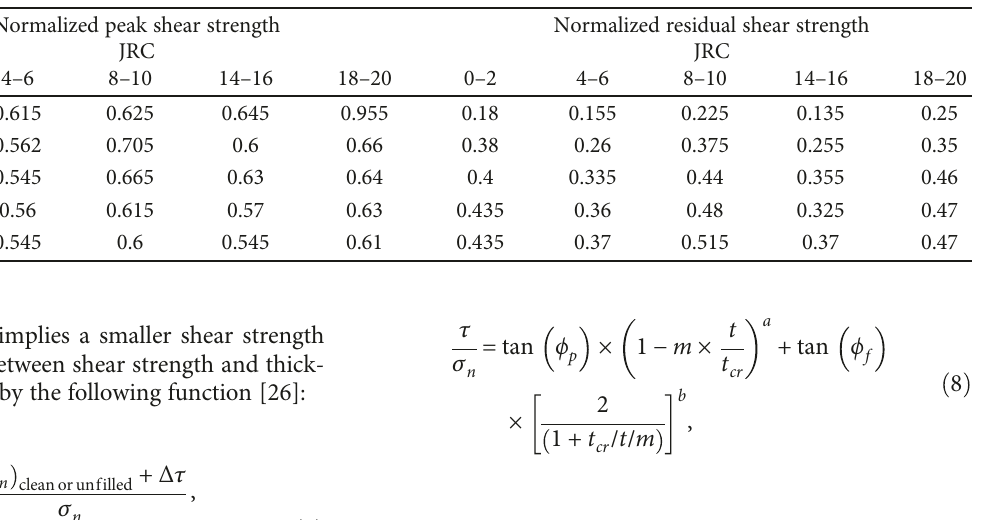
Figure 6: Relation between the in fi ll thickness ratio and normalized shear and residual strengths. (a) Normalized peak shear strength versus thickness ratio. (b) Normalized residual shear strength versus thickness ratio. Table 3: Normalized peak and residual shear